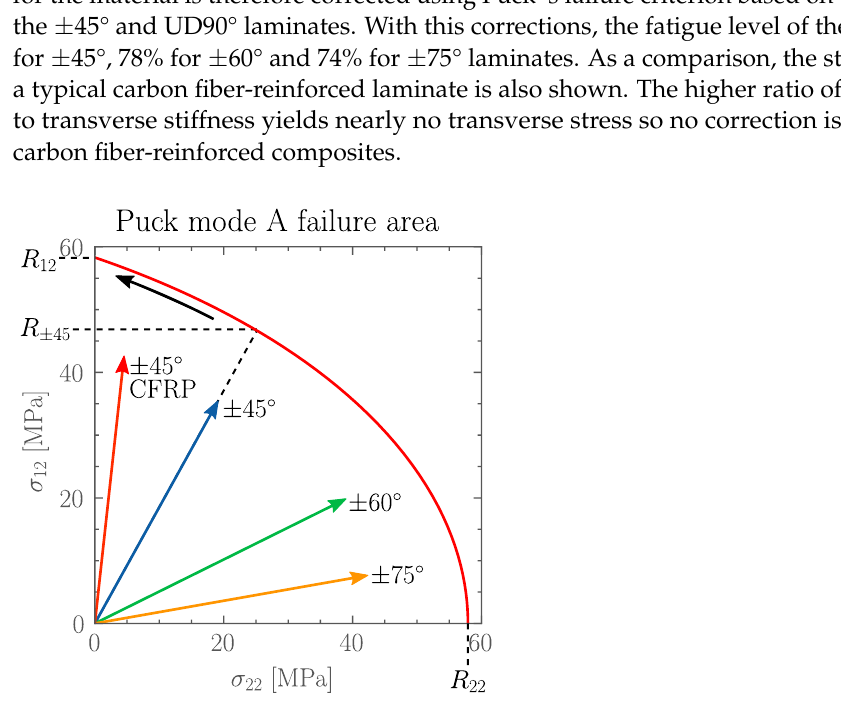
Figure A1. Puck mode A failure area (red) with stress vectors of the tests. In the ± 45° laminate, significant transverse stress σ 22 is present. Therefore, the in-plane shear strength R 12 is corrected with Pucks failure criterion (black arrow). As a comparison, the stress vector for a typical ± 45° CFRP laminate is also shown (red